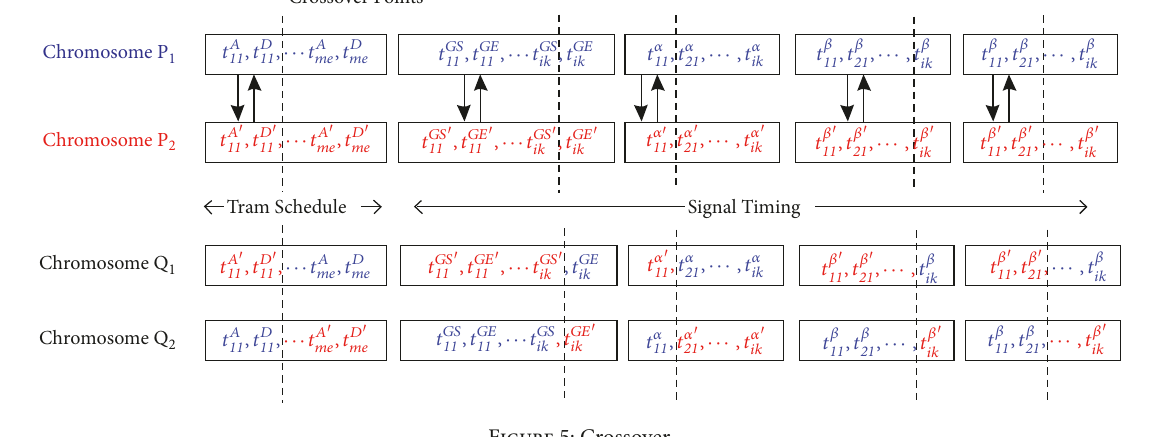
Figure 5: Crossover. Table 4: Traffic volume and signal timings.